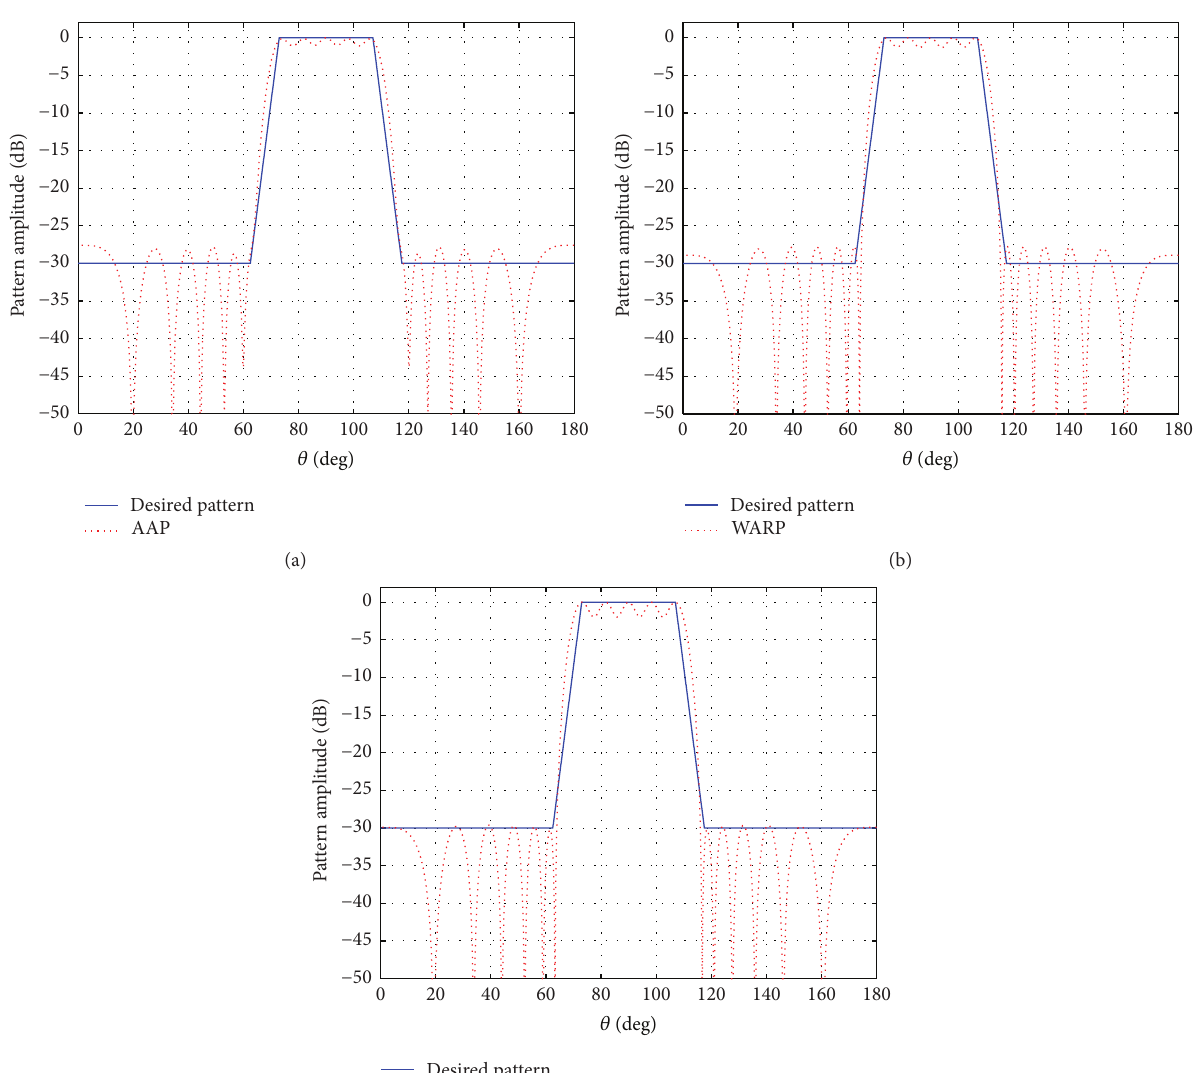
Figure 1: Pattern of FTP synthesis. (a) AAP method, (b) WARP method, and (c) proposed method.